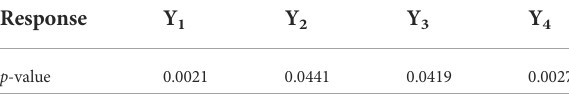
TABLE 7 Probability value of selected responses and regression coef fi cient of applied